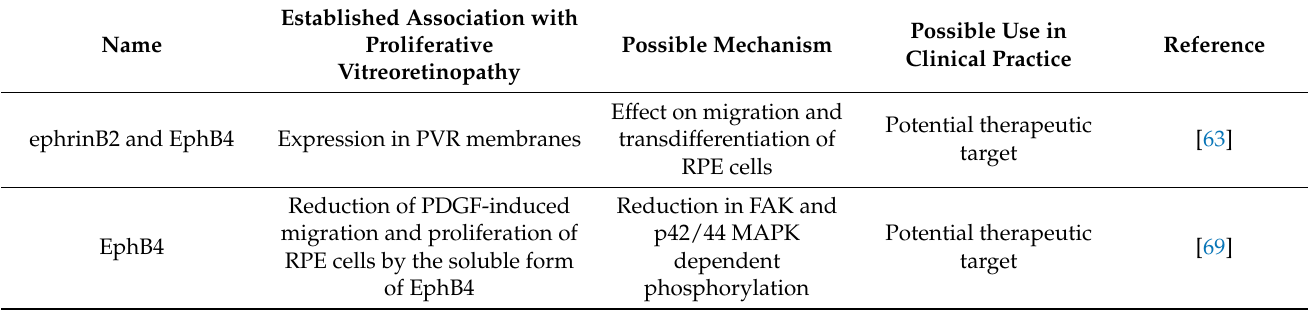
Table 3. A summary of the identified associations of Eph and ephrins with proliferative